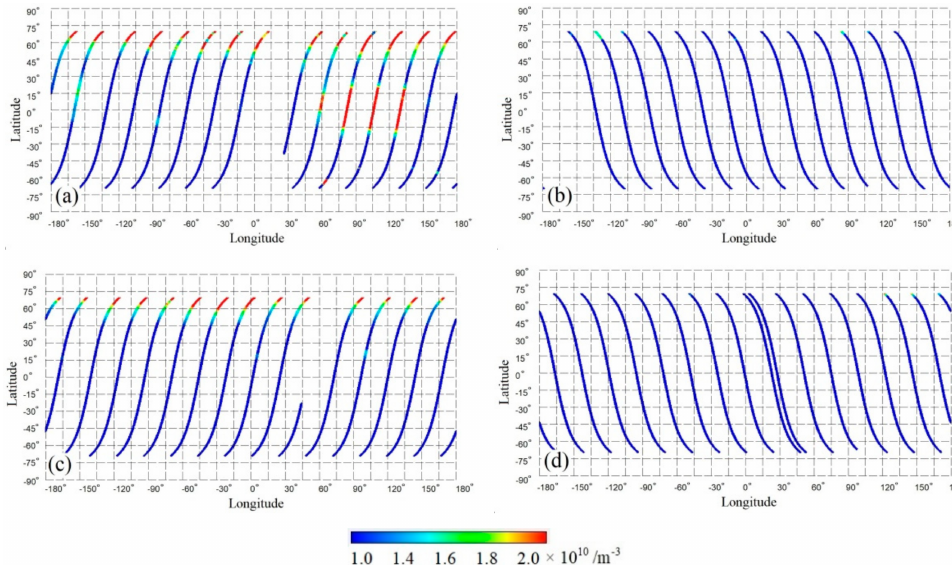
Figure 3. Variations in Ni (O+) on ( a ) 26 August 2018 daytime, ( b ) 26 August 2018 nighttime, ( c ) 24 August 2018 daytime, and ( d ) 24 August 2018